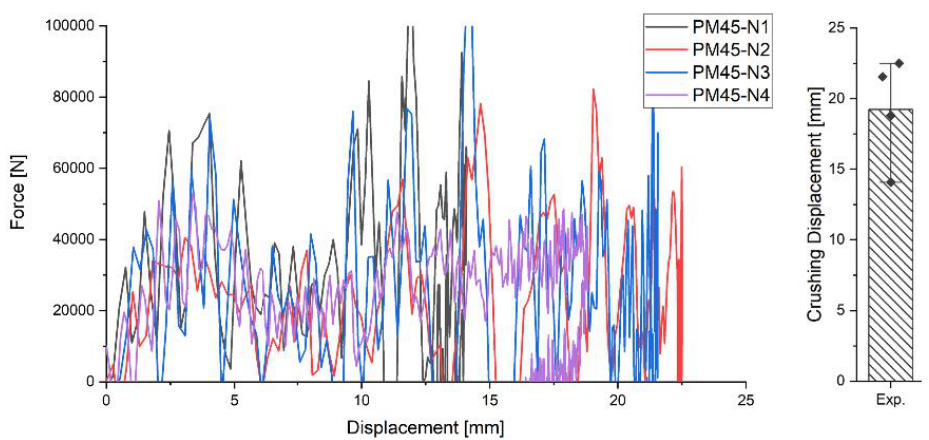
Fig. 2 . Experimental force-displacement curves (left) and total crushing displacements